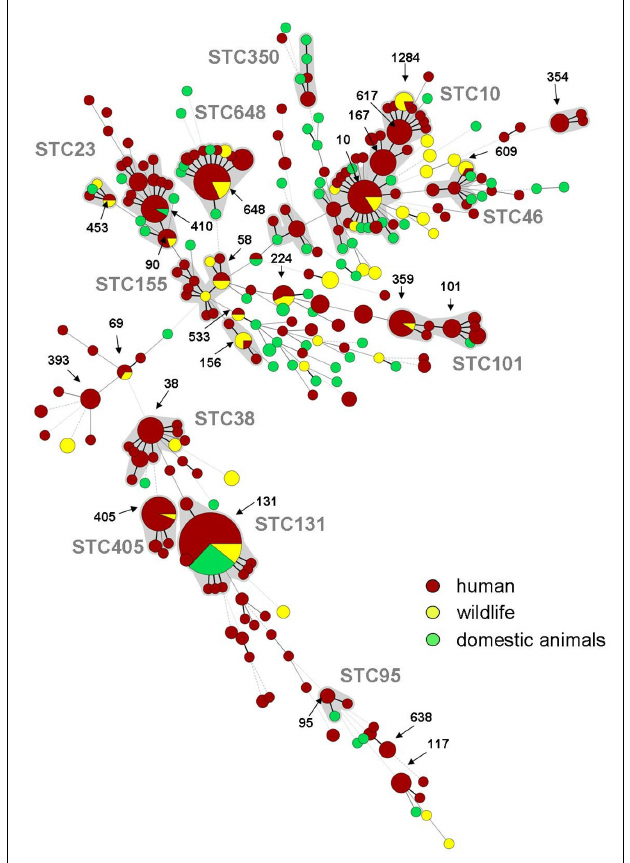
FIGURE 1 | Minimum spanning tree (MSTree) of human, domestic animals, and wildlife sequence types known for the production of ESBLs based on data of the MLST database (http://mlst.ucc.ie/mlst/ dbs/Ecoli; n = 288 isolates identifiable as ESBLs, October 2011), previously published articles with human clinical background (Minarini et al., 2007;Yumuk et al., 2008; Blanco et al., 2009; Hrabak et al., 2009; Naseer et al., 2009; Oteo et al., 2009; Suzuki et al., 2009; Valverde et al., 2009; Coelho et al., 2010; Cortes et al., 2010; Peirano et al., 2010; Smet et al., 2010a; Zong andYu, 2010; Ben Slama et al., 2011; Djamdjian et al., 2011; Leverstein-Van Hall et al., 2011; Mshana et al., 2011;Van Der Bij et al., 2011;Woerther et al., 2011) and data on wildlife given inTable 1. Red: human isolates, Green: domestic animals, Yellow: wildlife, Gray underplayed: Sequence type complexes, calculated with Bionumerics 6.6 (Applied Maths,